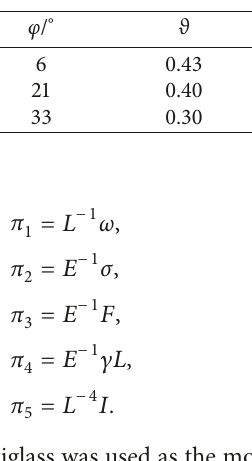
Figure 1: Geological and foundation profile of the HZMB tunnel (m) [22]. Table 1: Soil